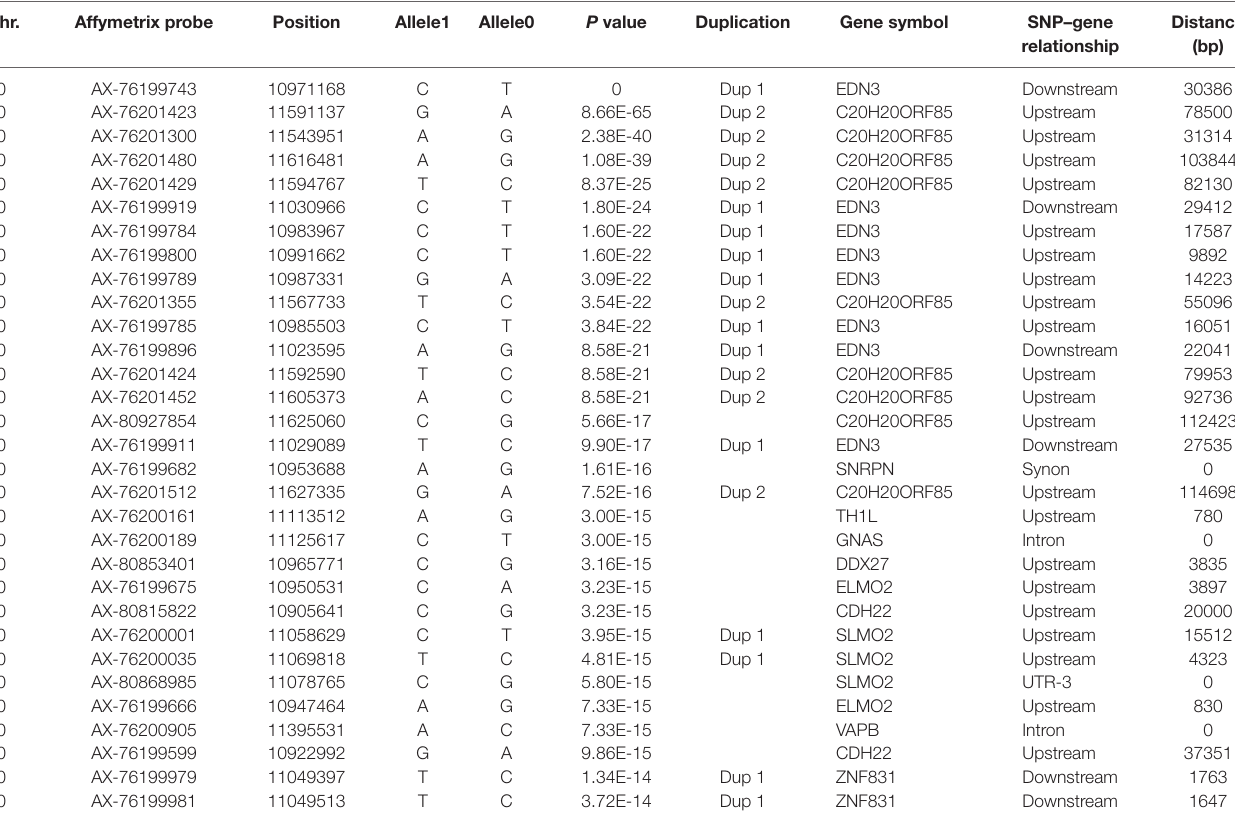
TABLE 2 | Significant single nucleotide polymorphisms (SNPs) with extremely high P values revealed by genome-wide association studies (GWAS) of comb color phenotype.